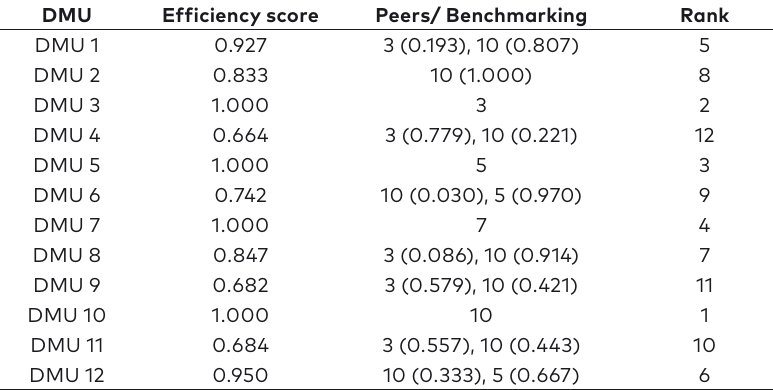
Table 3. Result of DEA for Framework 1